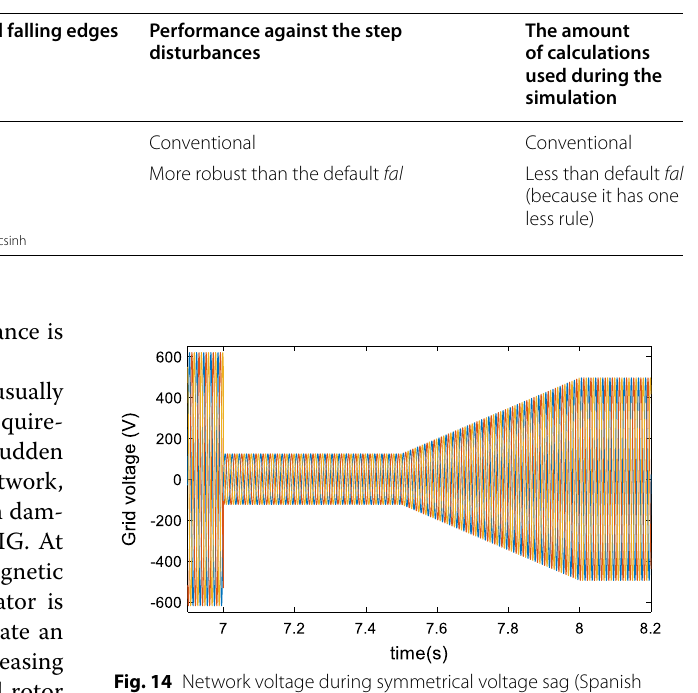
Performance against the step disturbances